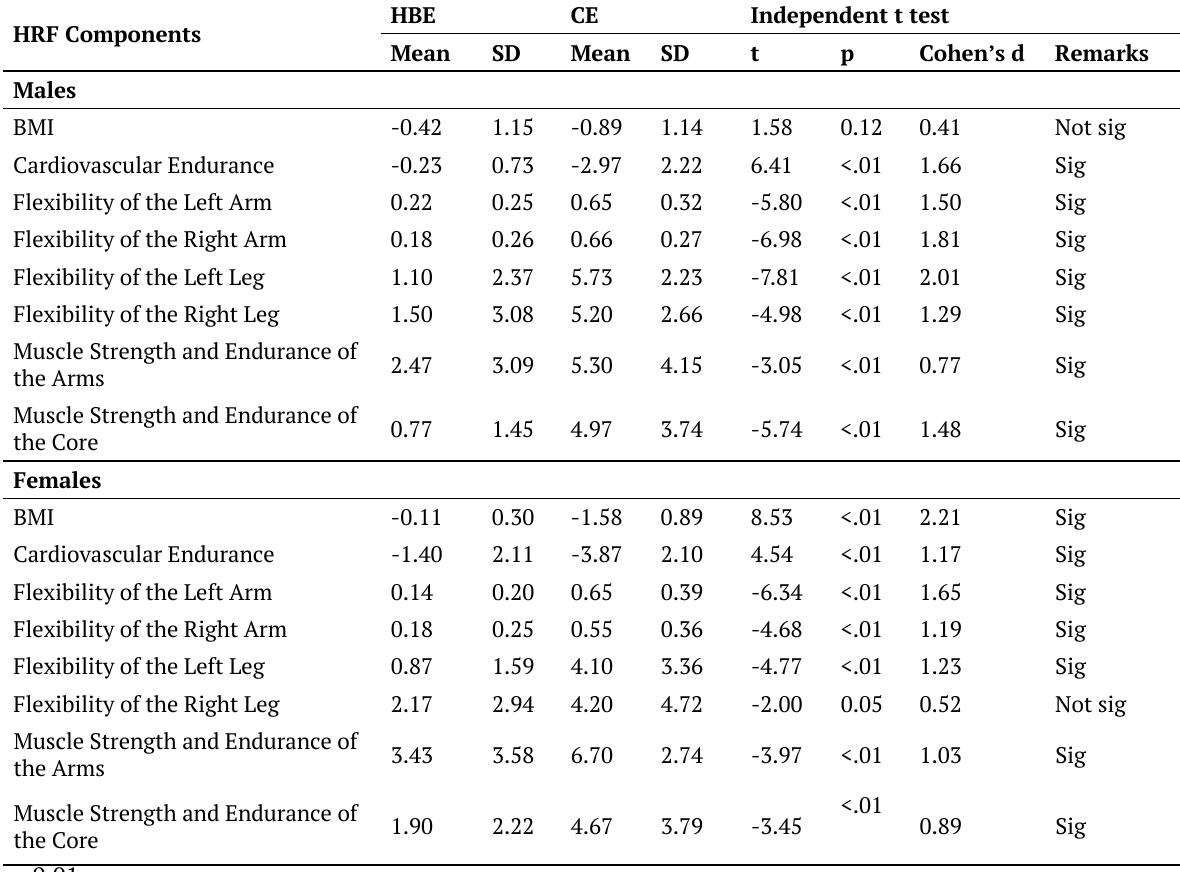
Table 4. Significant mean gain difference of participants (male vs. male, female vs female) in the HBE and CE groups.